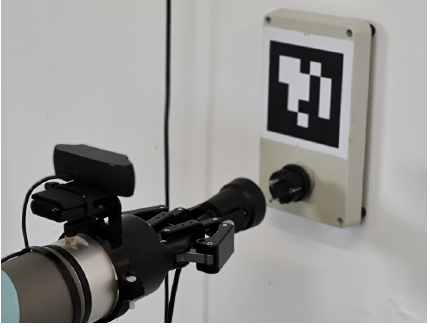
Figure 9. Move gripper to the approach waypoint.